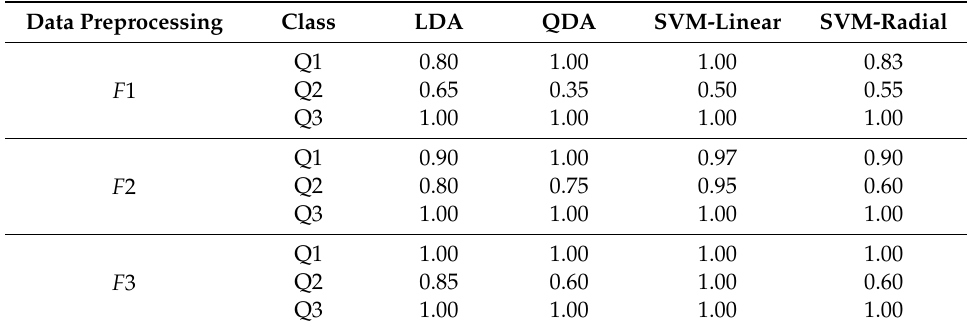
Table 3. Sensitivity values (correct classification rate, i.e., true positive rate) achieved for the external validation dataset (testing dataset), per grouping class.